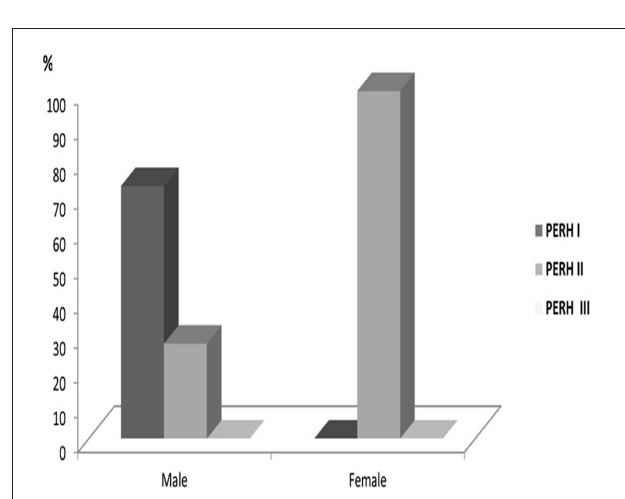
FIGURE 5 | Comparison of 13–18-year-olds male and female patients by PERH types in Group B. The PERH- I is high in males, while in the females revealed PERH